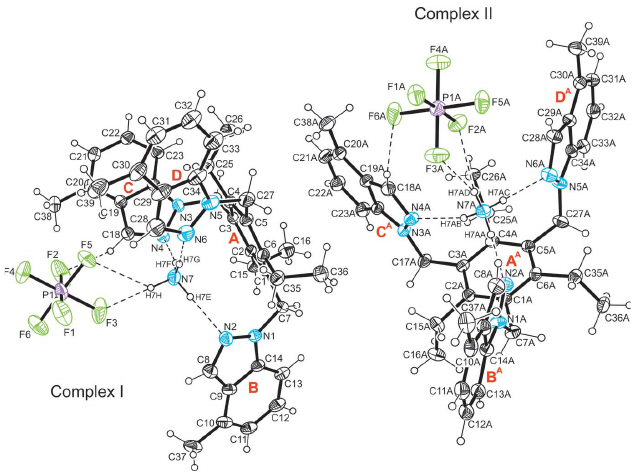
Figure 1 Perspective view of the title complex C 39 H 42 N 6 (cid:2) NH 4 + (cid:2) PF 6 (cid:3) including the labelling of non-hydrogen atoms. Displacement ellipsoids are drawn at the 50% probability level. Dashed lines represent hydrogen-bonding interactions.